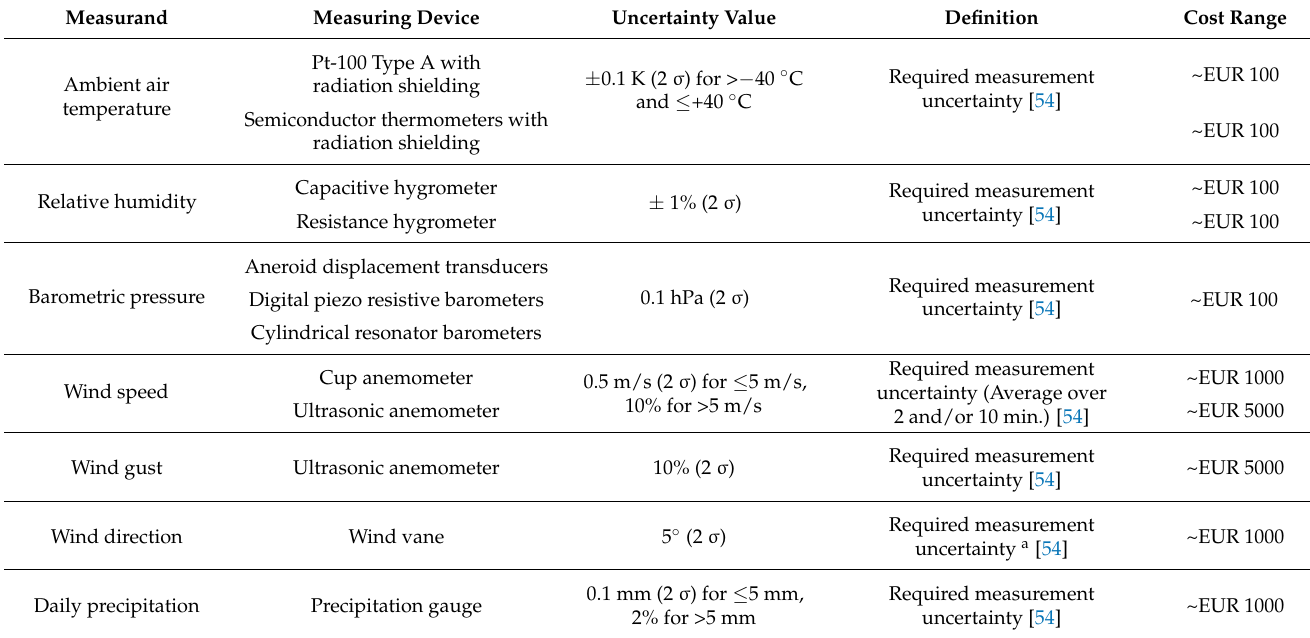
Table 4. Measurand, measuring device, measuring uncertainty and approximate cost range for additional meteorological measurement equipment in parabolic trough collector